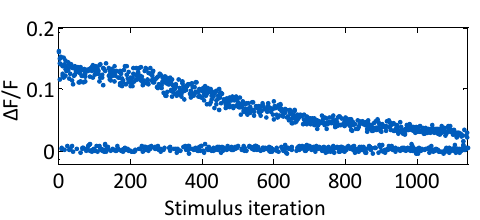
Figure 3. Evoked fluorescence decays due to photobleaching. The progression of the relative fluorescence change, Δ F/F, is shown across an experiment.